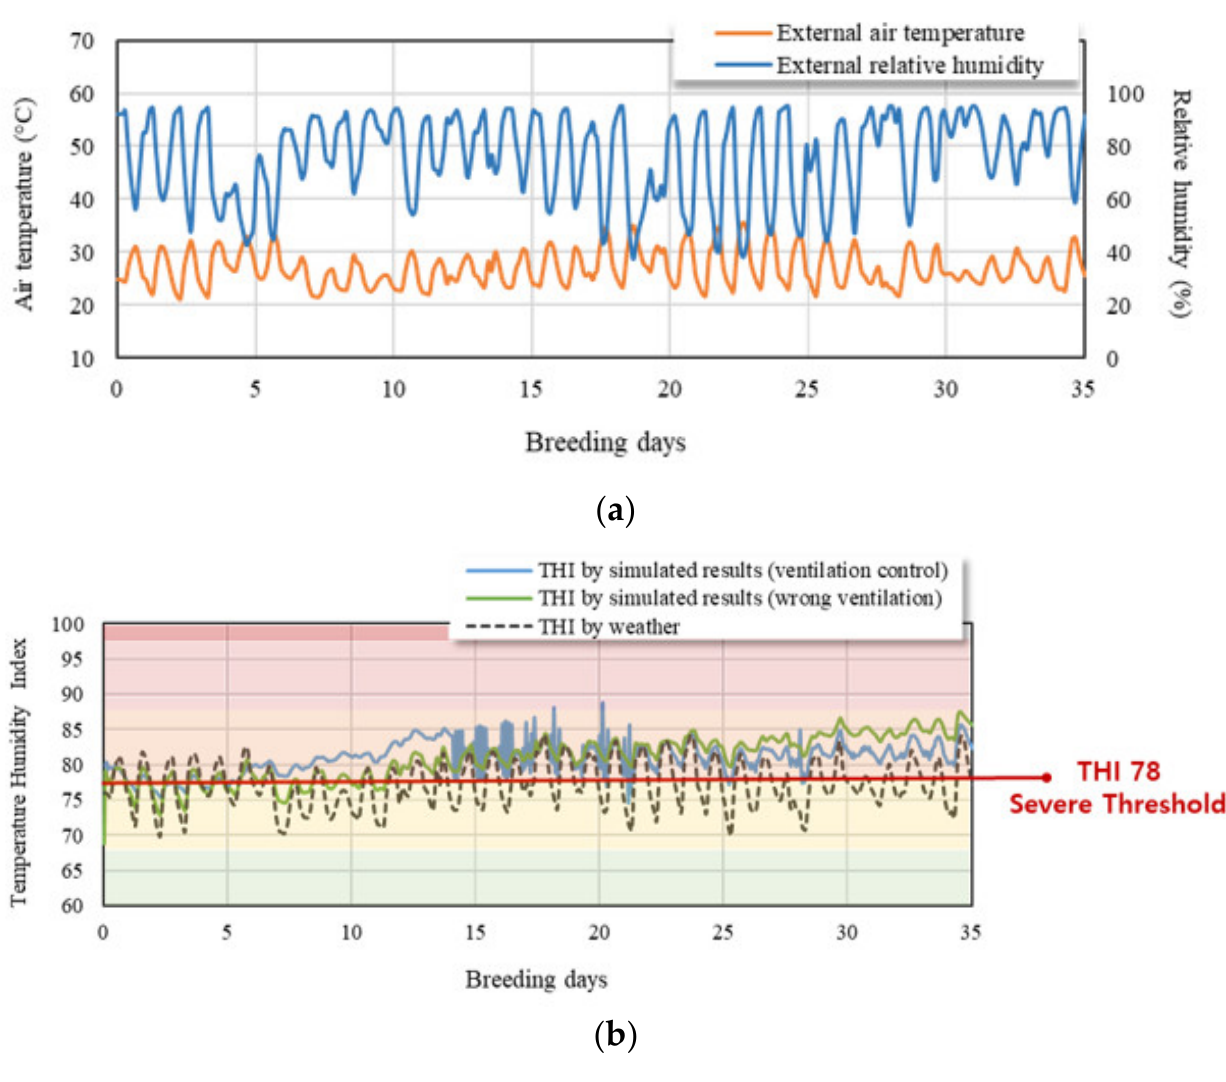
Figure 12. Comparison of heat stress index for the Rural Development Administration system predictive warning and this research model: ( a ) Jeonllabuk-do Weather Data (15 July–19 August); ( b ) Heat stress index analysis using energy model calculation results and experimental data.